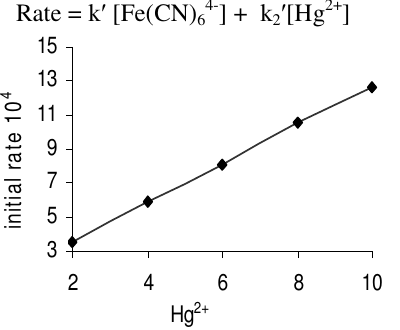
Figure 6. [Fe(CN) 64- ] = 8 x 10 -4 M, [EDTA] = 5 X 10 -4 M, pH = 5, temp. = 25 0 C, I = 0.1 M (KNO The value of the initial rate (V